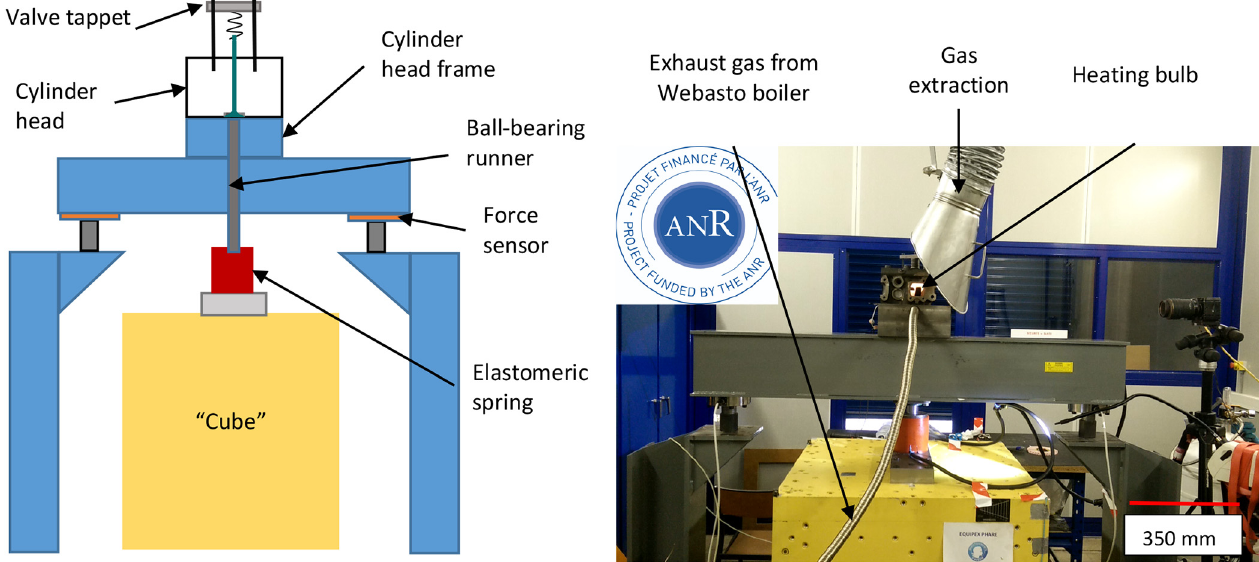
Fig. 25. Experimental setup performed on the “ Cube ” for tribological analysis of the valve-seat